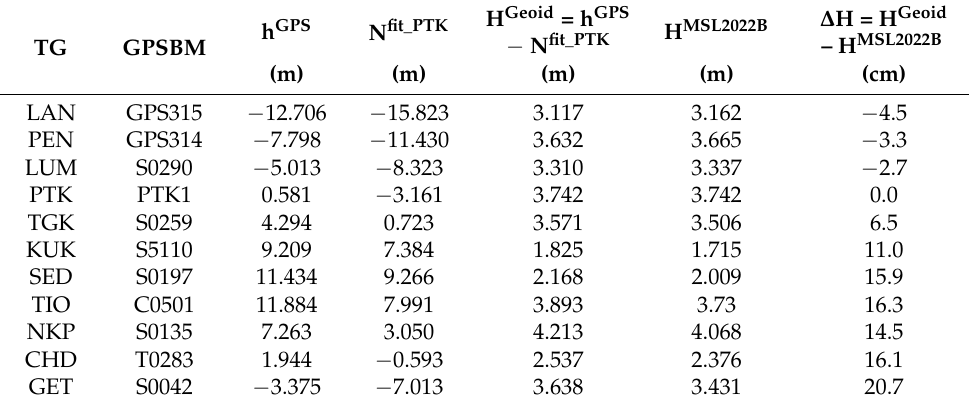
Table 12. GPS levelling result by fitting PMGeoid2022 to MSL2022B at Port Klang tide gauge station, revealing relative geodetic-MDT between MSL2022B at Port Klang and MSL2022B at other tide